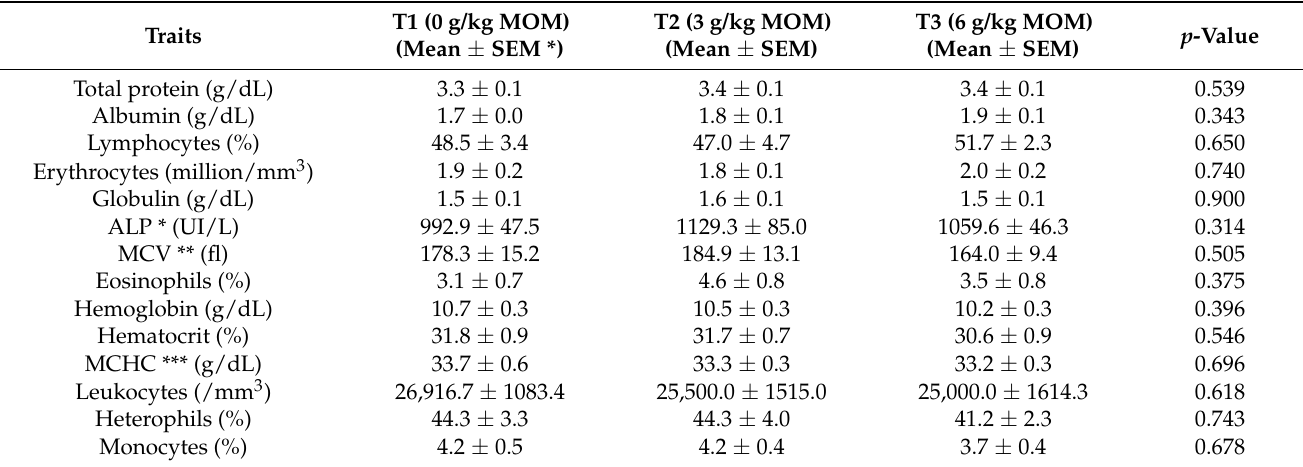
Table 6. Health status of slow-growing Dominant CZ Blue D 107 male chickens raised with Moringa oleifera meal (MOM) in a tropical